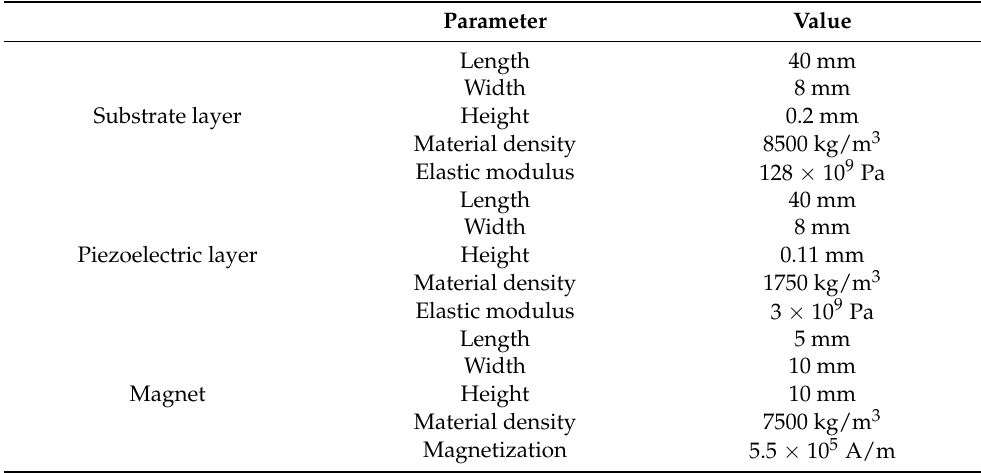
Table 1. Structure and material parameters of CTPEH.